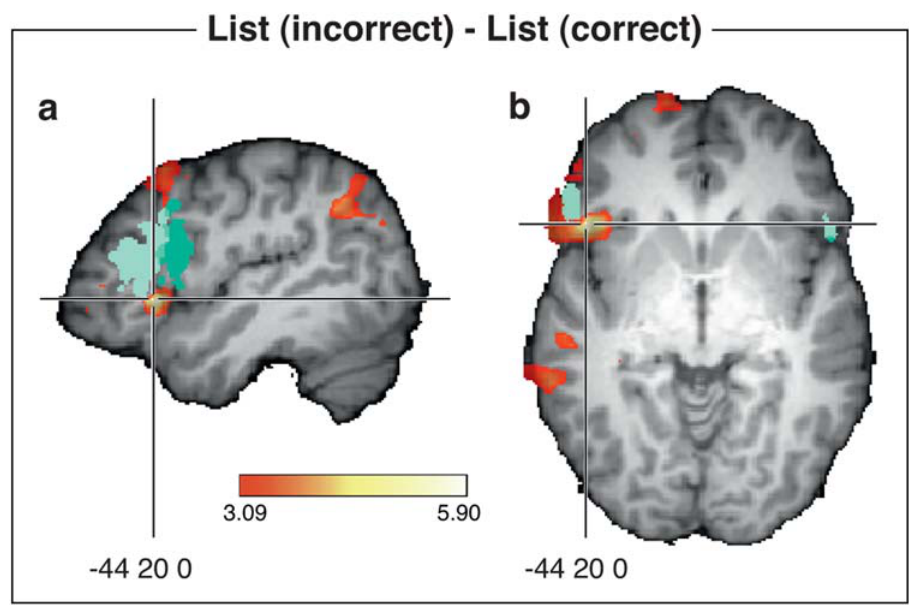
Figure 3. The figure shows activation for incorrect flat sequences vs. correct flat sequences. FMRI data are mapped onto a reference brain (single subject), where areas differing significantly in activation are coloured red to yellow and correspond to values with Z w 3 : 09 (uncorrected). The cross hair is placed at ( 2 44, 20, 0) in the Talairach co-ordinate system. Views: (a) sagittal x ~{ 44 and (b) axial z ~ 0 . The entire region marked in green in (a) and (b), corresponds to the cytoarchitectonically defined Broca’s area with a probability of at least 50% according [13]. Light green corresponds to Brodmann area BA 45, and dark green to BA 44.